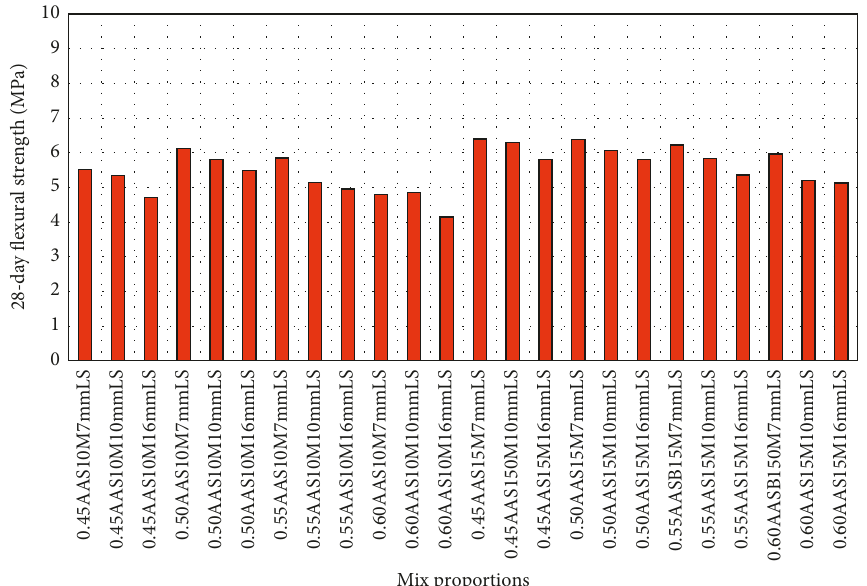
Figure 8: 28-day flexural strength of the